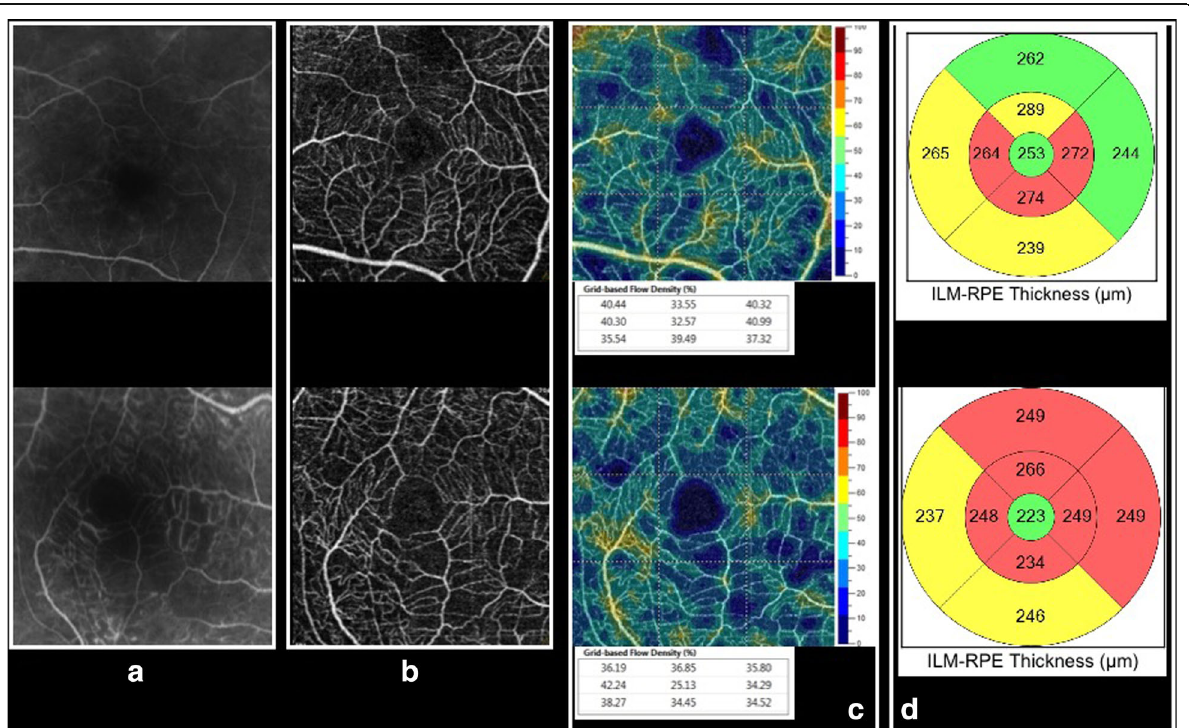
Fig. 1 Comparison of fluorescein angiography and OCTA in posterior uveitis. Two eyes of two patients with chronic birdshot chorioretinopathy illustrate mild leakage on fluorescein angiography ( a ) that masks or blocks areas of reduced flow. OCTA more accurately highlights the zones of non-perfusion in the superficial retinal capillary plexus ( b ). Note the generalized reduction in blood flow velocity (highlighted in blue) that is evident in the color-coded OCTA map ( c ) that can also provide quantitative parameters. The areas of flow reduction on OCTA corresponds to a thinning of the retina on the OCT map ( d ) that has been described in the literature in advanced stages of